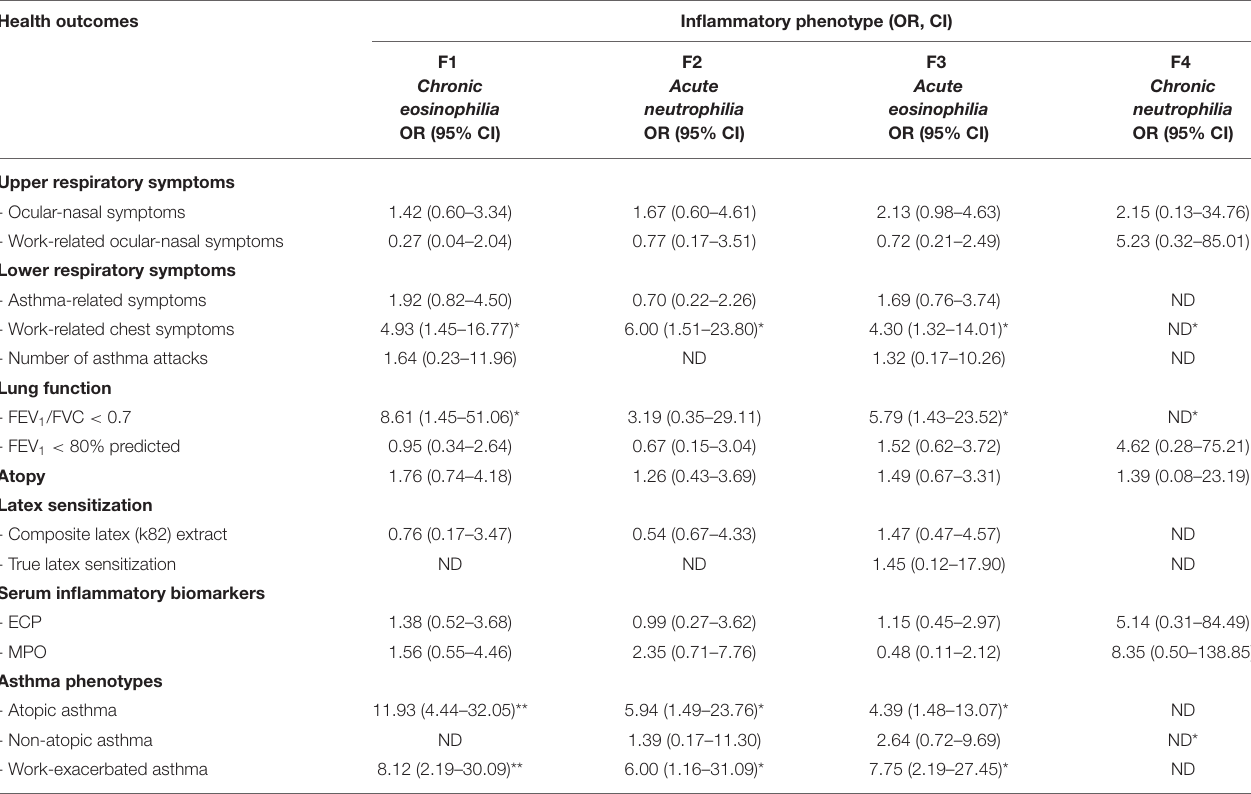
TABLE 5 | Association between asthma related clinical indices and inflammatory phenotypes identified in dental healthcare workers ( n = 76) in multivariate logistic regression